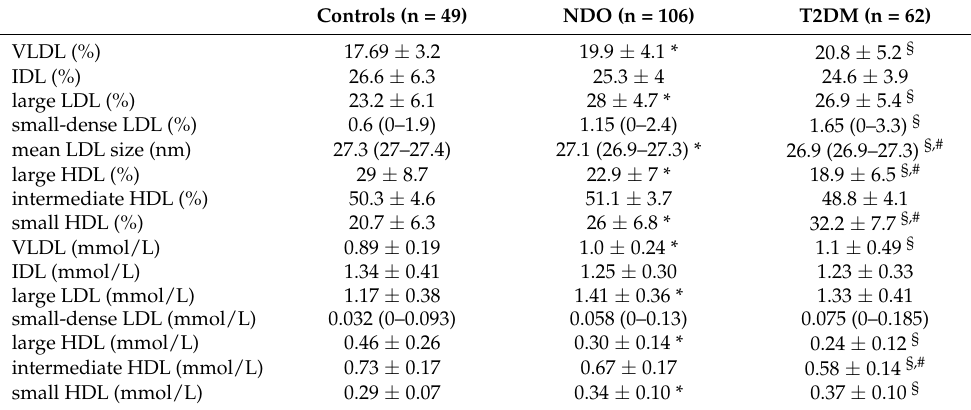
Table 2. Percentage and absolute amount of lipoprotein subfractions in study participants.